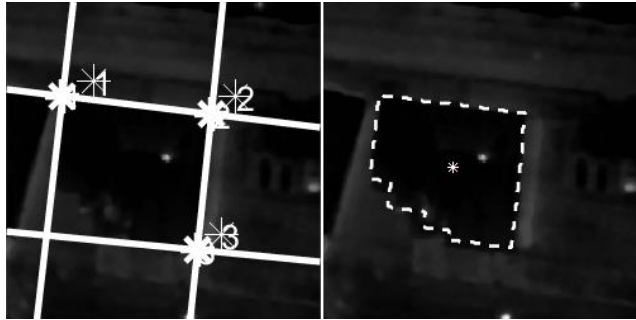
Fig. 5. Image to the left. White lines show significant lines found in the image and the white star marks matched GCPs. Image to the right: a white dotted line shows the transformed polygon